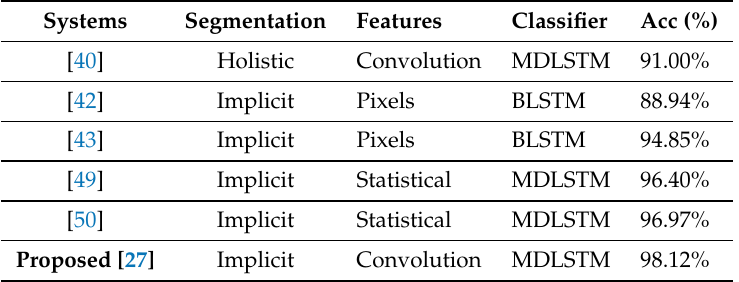
Table 3. Comparison of Urdu recognition on UPTI